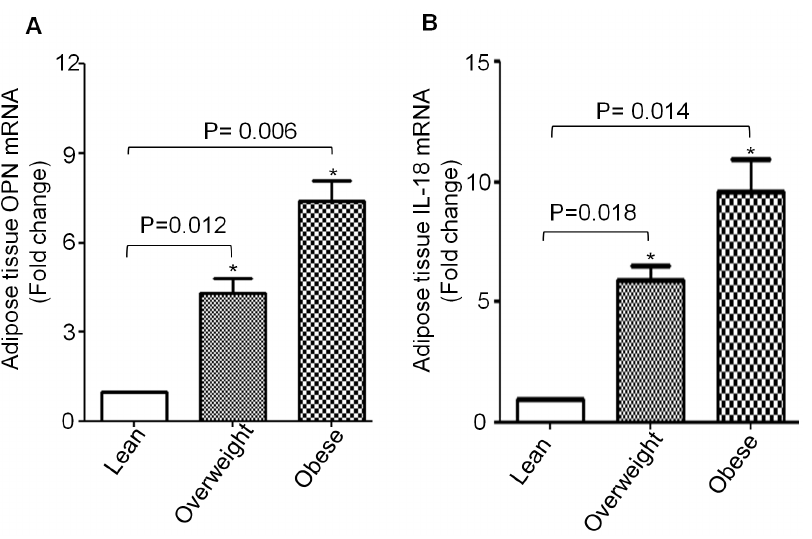
Figure 3. Expression of OPN and IL-18 mRNA in adipose tissue. Adipose tissue samples from 9 (lean: 3, overweight: 3 and obese: 3) individuals with different BMI were subjected to total RNA isolation. OPN and IL-18 mRNA expression was determined by real time quantitative RT- PCR. Relative mRNA expression was expressed as fold expression over average of gene expression of lean group. The expression level in lean group was assumed to be 1. Values are presented as mean 6 SE (A and B).